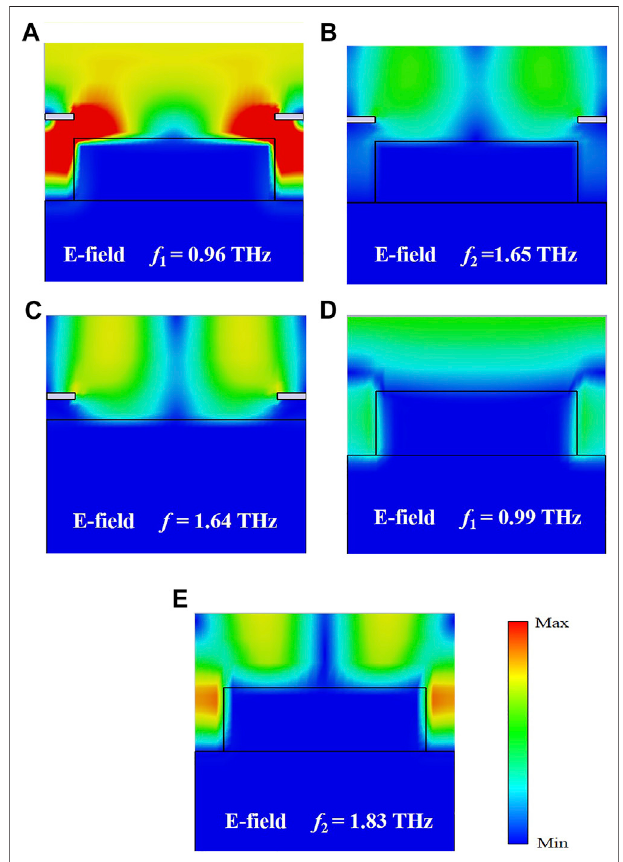
FIGURE 2 | (A,B) Electric fi eld intensity distribution of the proposed CMMC at 0.96 THz and 1.65 THz; (C) Electric fi eld intensity distribution of the CM at 1.64 THz. (D,E) Electric fi eld distribution of the MC at 0.99 THz and 1.83